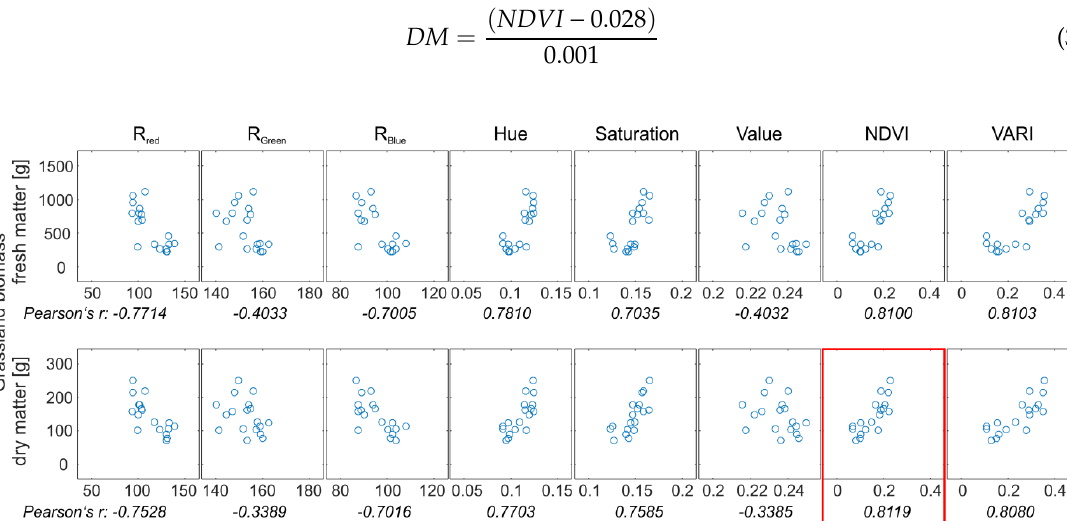
Figure 4. Scatterplots and correlations between fresh and dry matter weight of the grassland biomass and multi-spectral indices deduced from the UAV-based aerial photographs.